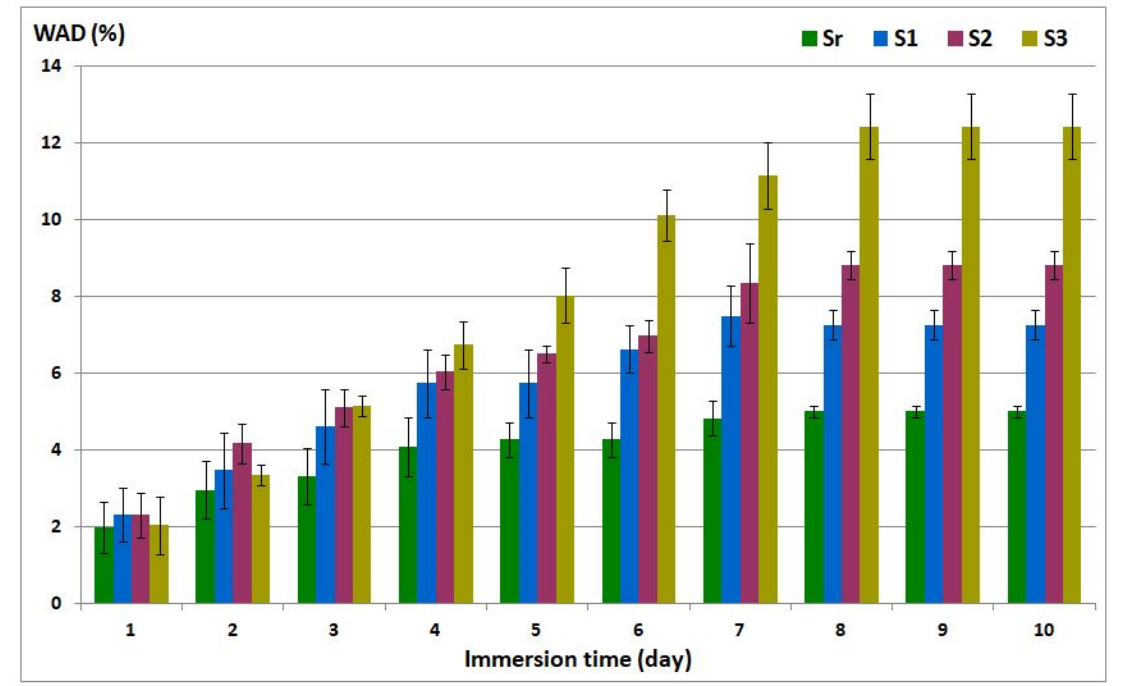
Figure 6. Water absorption degree for ELO-LnK composites.